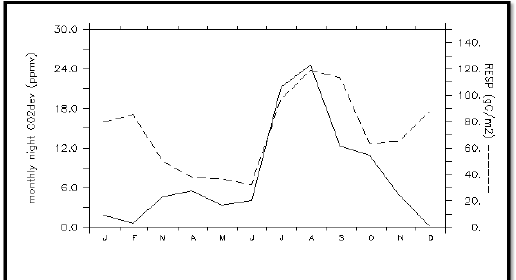
Figure 6: Comparison between night time CO 2 and simulated soil-respiration during different months in 2009.